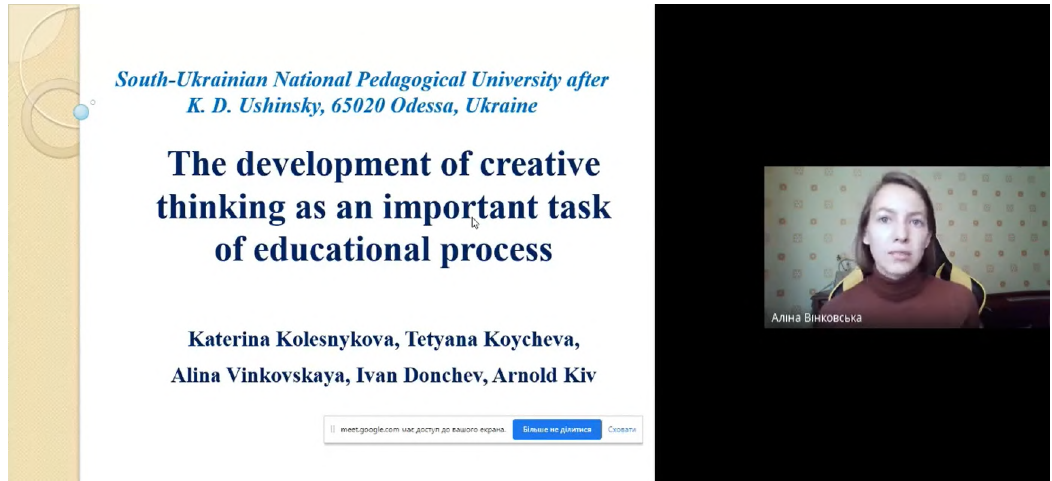
Figure 92: Presentation of paper